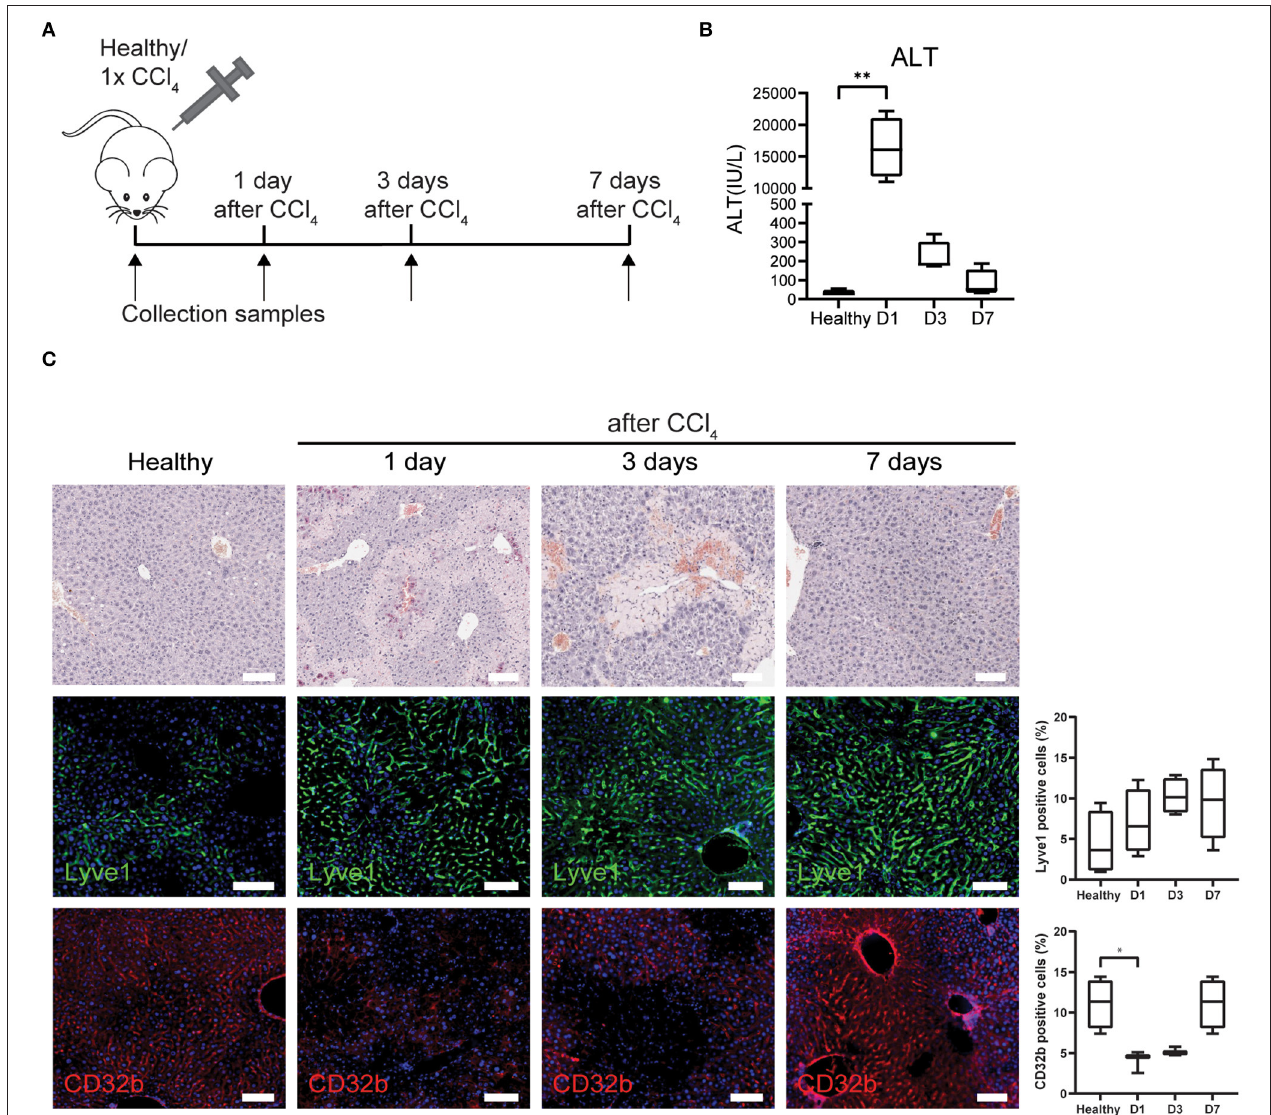
FIGURE 3 | LSECs in healthy livers or acute liver injury. (A) Isolation of LSECs from healthy livers and from livers after 1, 3, and 7 days after CCl 4 injection. (B) ALT levels of healthy mice and mice that received CCl 4 ** P ≤ 0.01. (C) Immunohistochemistry with hematoxylin eosin staining and immunofluorescence staining and quantification of Lyve1 and CD32b (* P ≤ 0.05) on livers from healthy mice or mice that received CCl 4 (bar = 100 µ